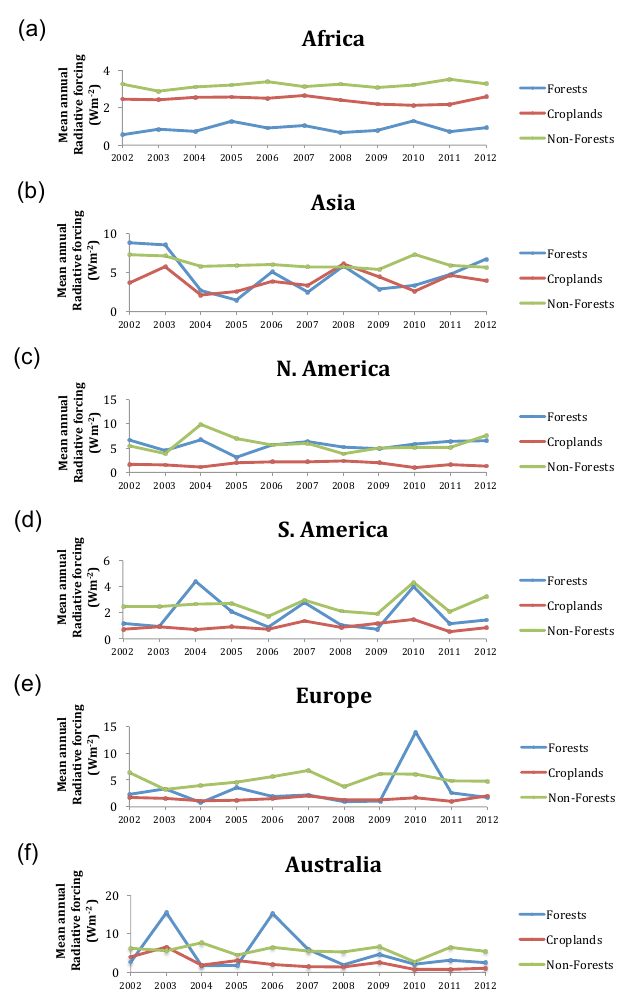
Figure 3. The mean annual radiative forcing per land cover and continent (a–f)